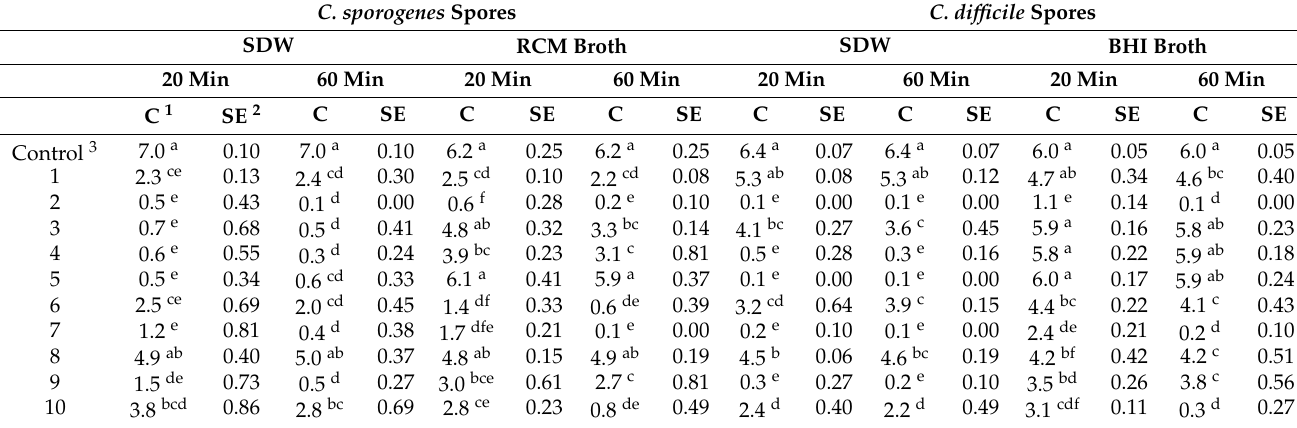
Table 2. The spore counts (log 10 CFU/mL) after treatment with the different disinfectants for 20 and 60 min. C. sporogenes